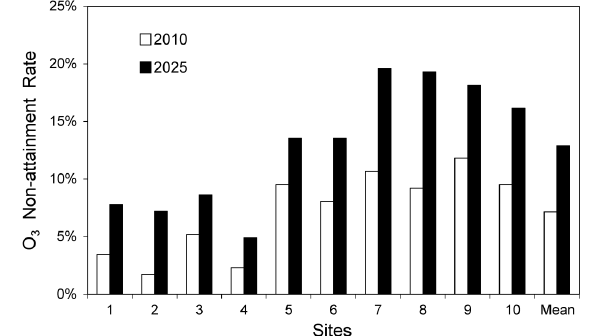
Fig. 11. PM 2.5 annual average concentration (µg m -3 ) in Guangzhou, 2010 and 2025. (Sites name from 1 to 9: Guangya, 5School, Jiancezhan, Tianhu, Guangshang, 86School, Panyu, Huadu, Jiulong).